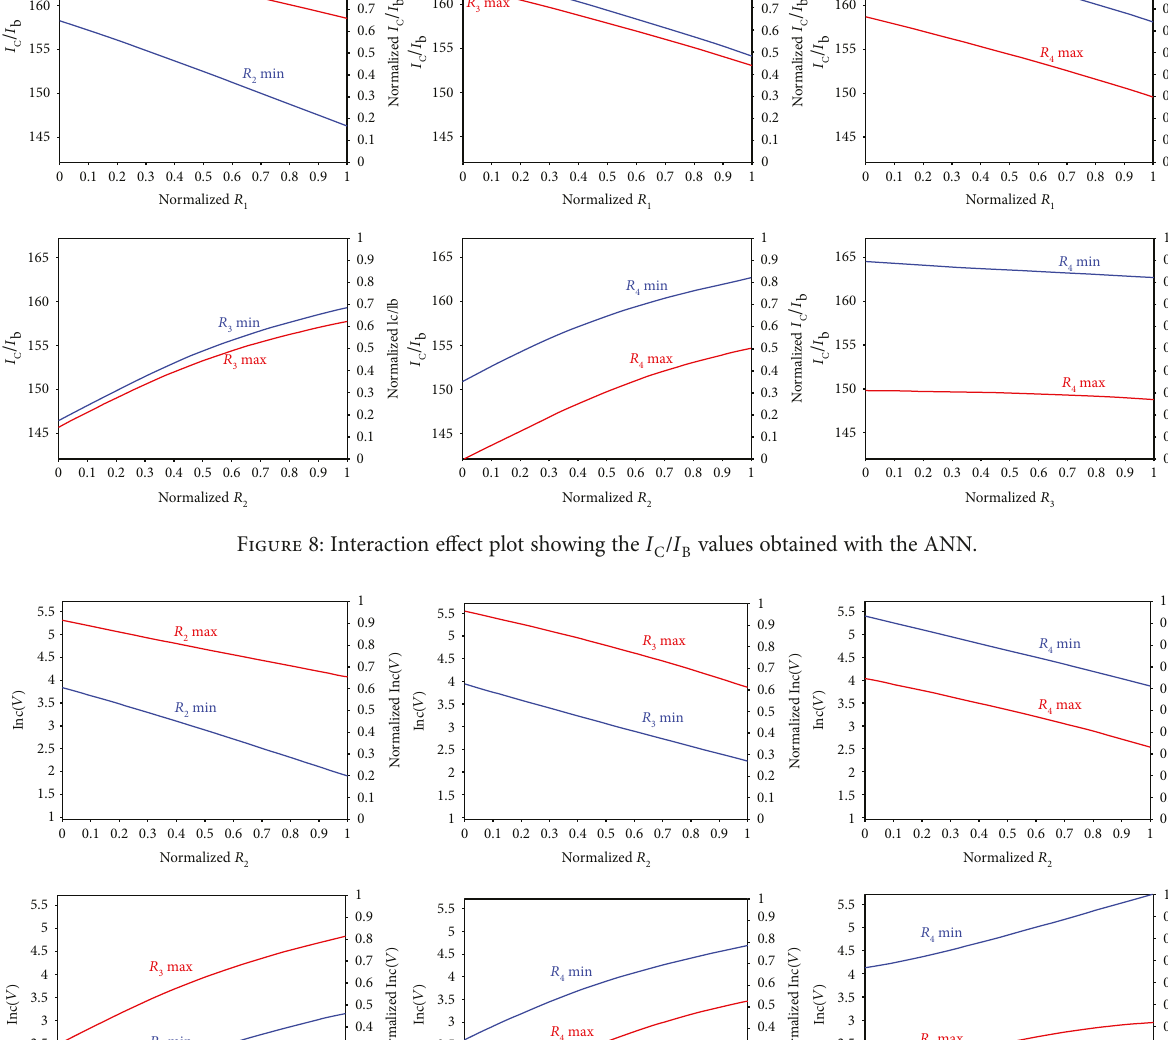
Figure 9: Interaction e ff ect plots for the Δ V obtained with the